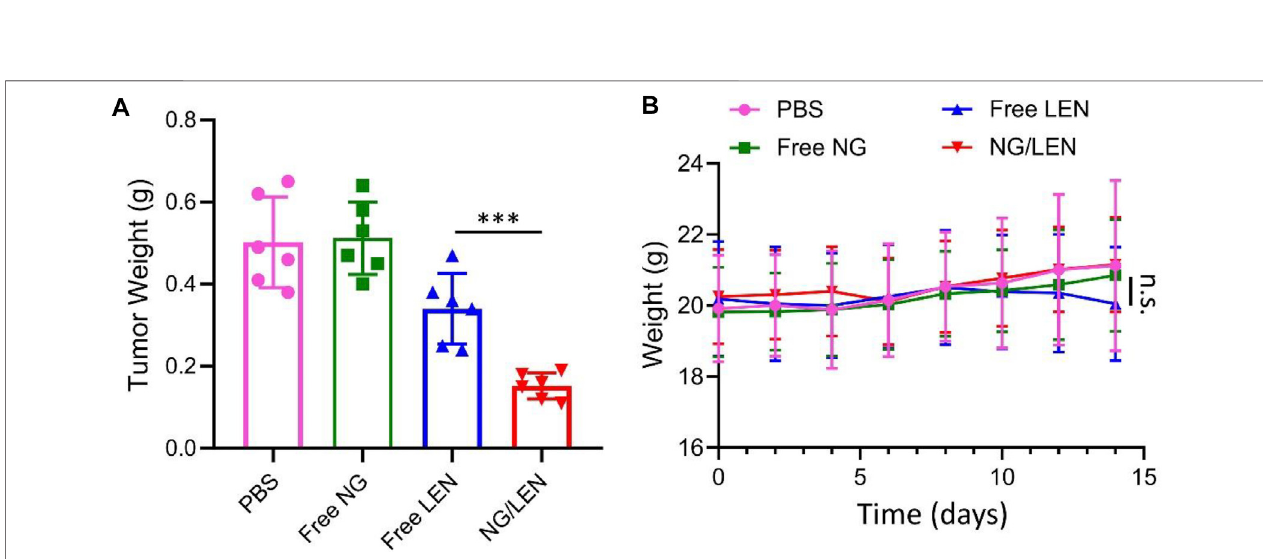
FIGURE 7 | (A) In vivo tumor inhibition ef fi cacies of PBS, free NG, free LEN, or NG/LEN on orthotopic model of HCC in BALB/c mice and (B) corresponding body weight change during treatment. Each set of data is represented as mean ± SD ( n (cid:1) 6; *** p < 0.001).